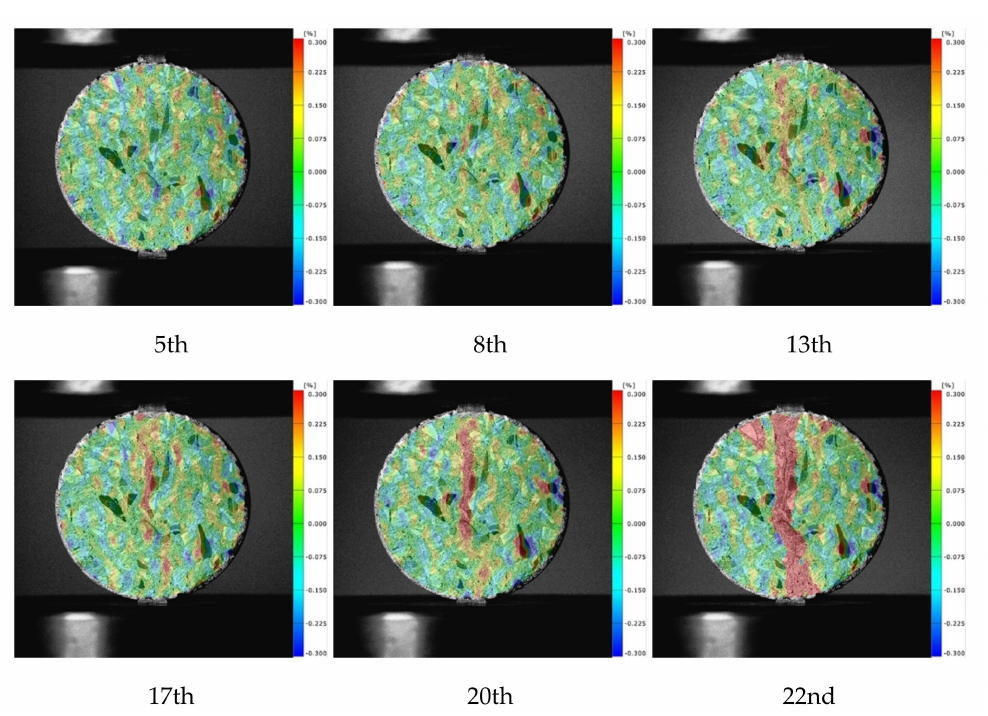
Figure 9. Strain maps of